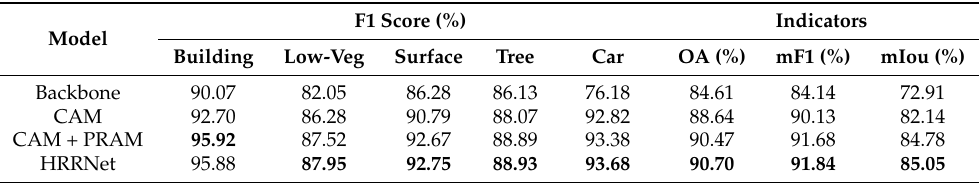
Table 4. Ablation results of the second set (on Potsdam data set), the optimal results are bolded.